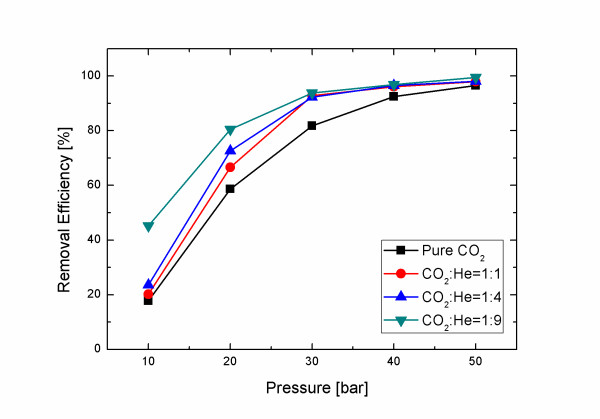
Removal efficiency of 10-nm Al2O3 particles on Si surface with 1/3 throat diameter.